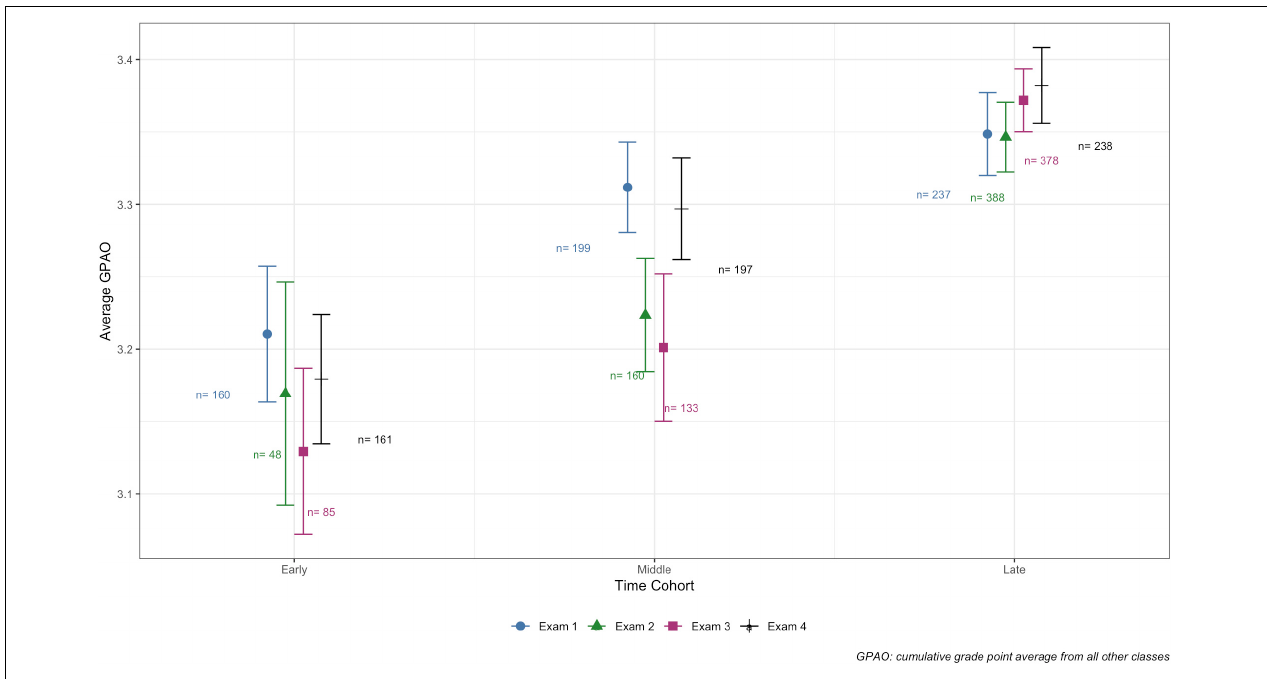
FIGURE 5 | Average GPAO as a function of time